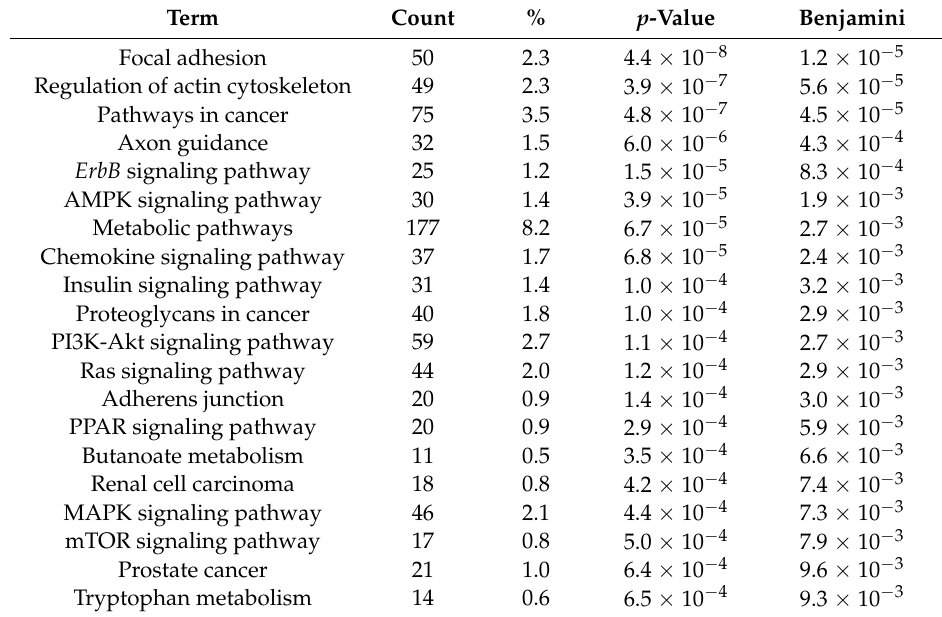
Table 2. Significantly regulated Kyoto Encyclopedia of Genes and Genomes (KEGG) pathways in the one-week-old offspring kidney born to mothers treated with melatonin versus